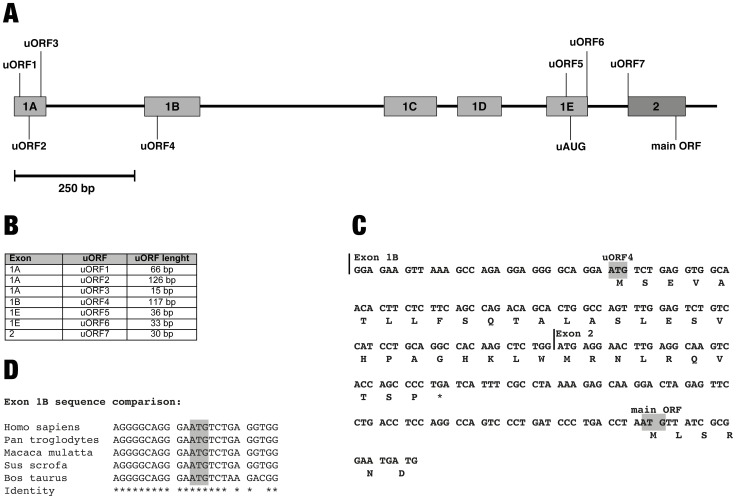
The LST1 5′-UTR contains several uORFs.
(A) Schematic overview of the LST1 5′ exons. All LST1 transcripts contain one of the noncoding exons 1A–E, which include transcription initiation sites, followed by the exon 2 sequence, which contains the start codon of the main ORF. The five alternative exons 1A–E and the exon 2 sequence are displayed as grey boxes; introns are represented by black lines. The start codons of uORFs 1–7 are indicated; additionally an uAUG in exon 1E is annotated. (B) List of uORFs in the LST1 5′-UTR and their corresponding lengths in base pairs from start to stop codon. (C) Sequence of the LST1 5′-UTR in transcripts initiated at exon 1B. The exon 1B and exon 2 sequences are labelled; the AUGs of uORF4 and of the main ORF are highlighted in grey. The amino acids encoded are indicated beneath the nucleic acid sequence. (D) Sequence comparison of the exon 1B sequence flanking the start codon of uORF4. The sequence is conserved in pan troglodytes (sequence accession number NW 003457113.1), macaca mulatta (NW 001116486.1), sus scrofa (NW 003610614.1) and bos taurus (NW 003104557.1).